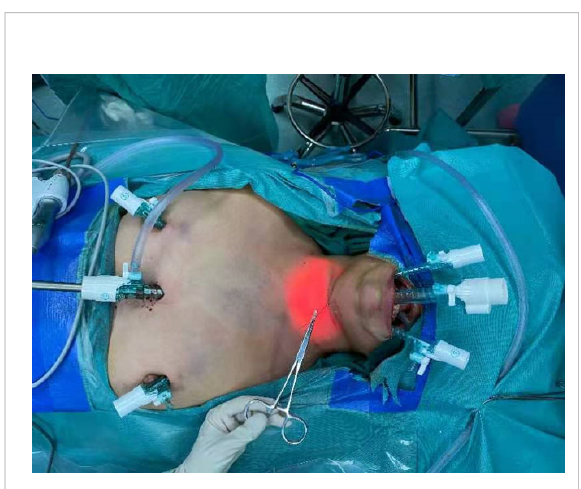
FIGURE 1 Representative image showing incision and trocar placement for endoscopic LND via the combined chest and transoral